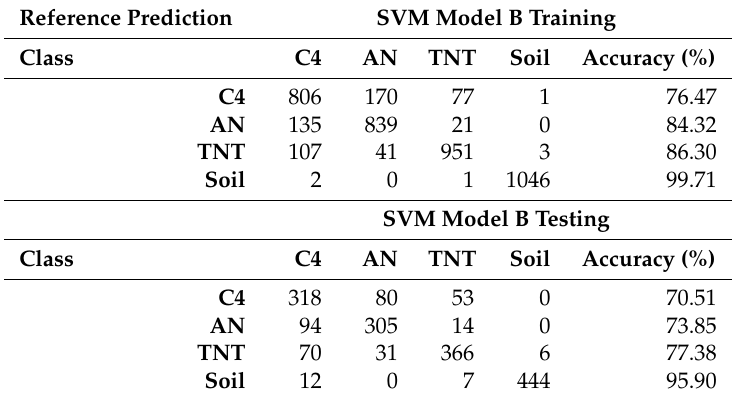
Table 5. Classification results of SVM model B on optimal